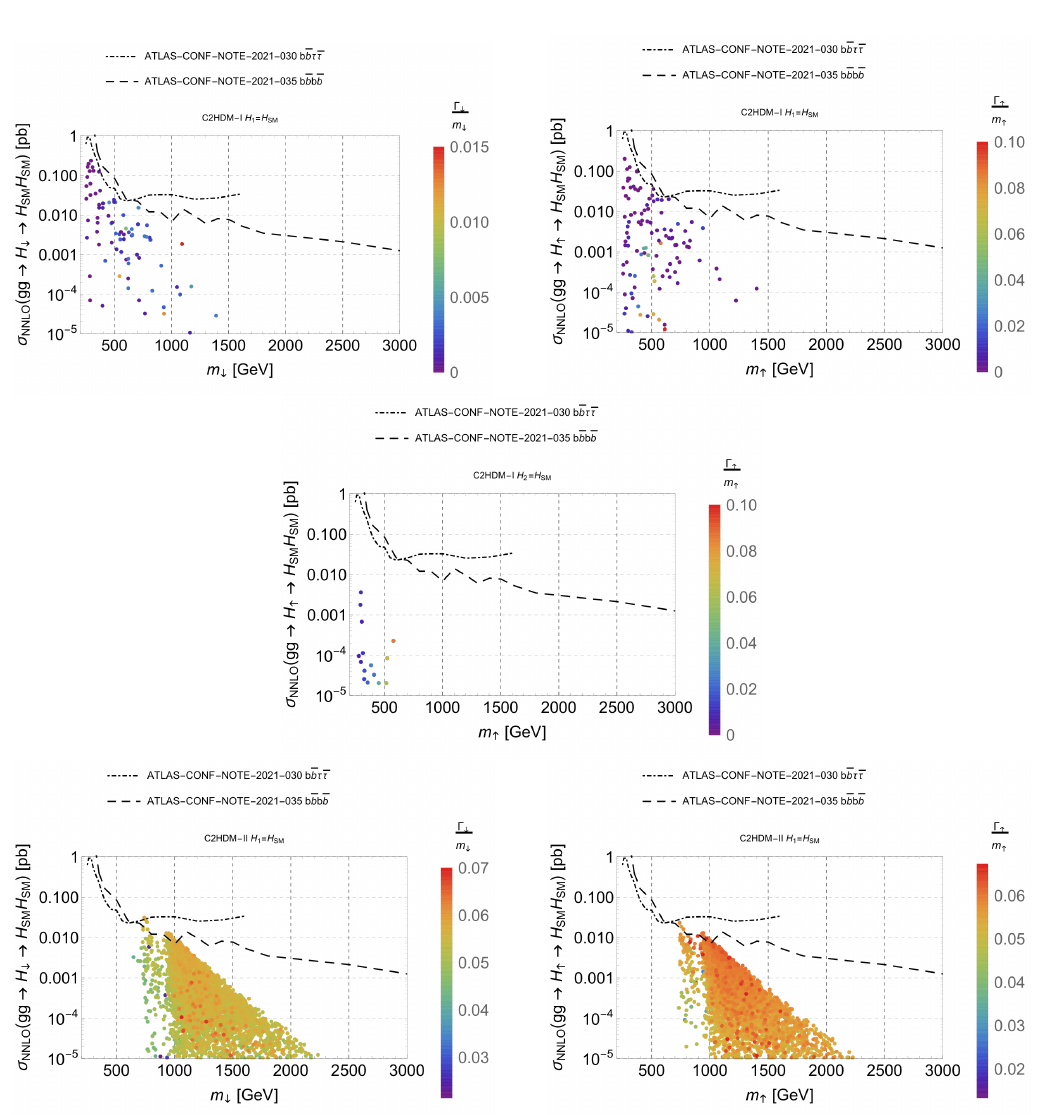
Figure 14 . Resonant production cross sections for the C2HDM points of figure 7 (middle) for C2HDM-I (upper two rows) and C2HDM-II (lower row) as a function of the resonantly produced heavier Higgs boson H or H . Color code: ratio of the total width of the resonant 2 ≡ H ↓ 3 ≡ H ↑ Higgs boson and its